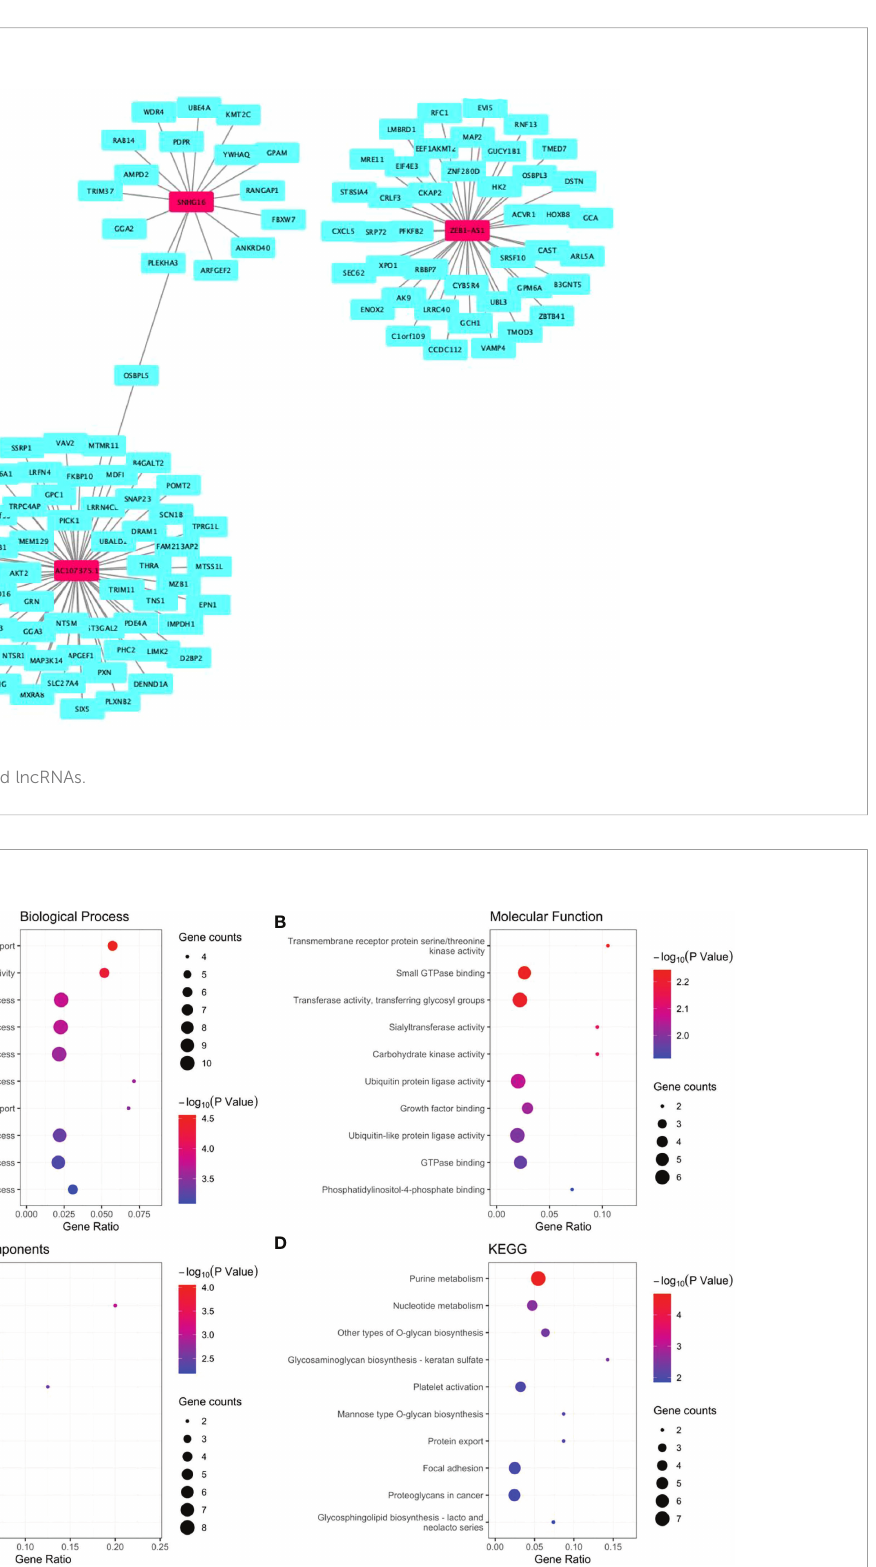
FIGURE 6 GO and KGEE analysis of the target genes: (A) Biological Process (BP) of target genes. (B) Molecular Function (MF) of target genes. (C) Cellular Components (CC) of target genes. (D) KEGG of target